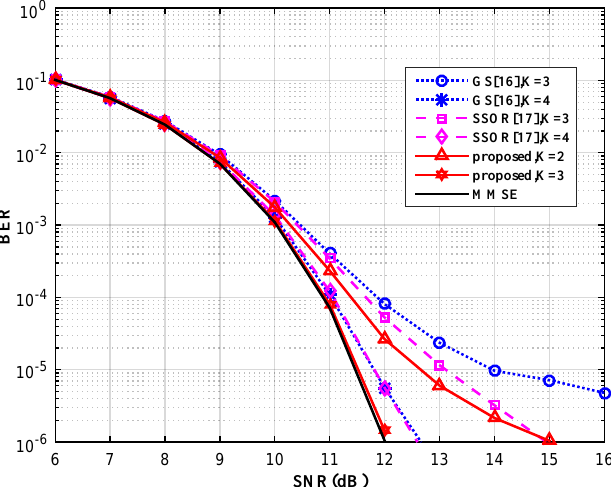
Figure 5. BER curves of the symmetric successive over-relaxation (SSOR), Gauss Seidel (GS) algorithms and the proposed Jacobi-based